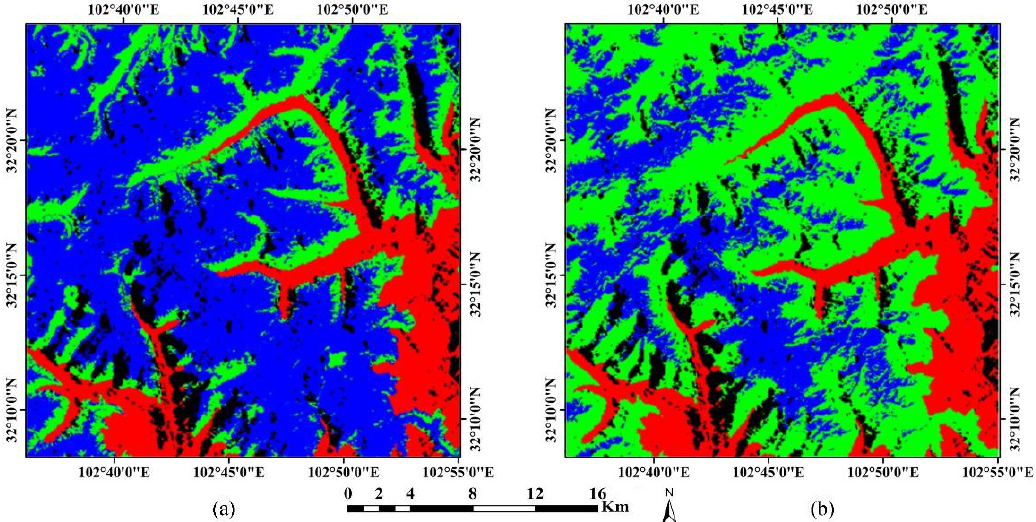
Figure 10. Snow maps using Landsat 5 image pairs. ( a ) The 9 February 2008 and 4 April 2008 pair. Areas in blue represent locations with snow increase. Areas without snow change are green. ( b ) The 4 April 2008 and 15 May 2008 pair. Areas with snow decrease are blue. Areas without change are green. In both (a) and (b), areas below tree line are red. The layover and shadow areas are